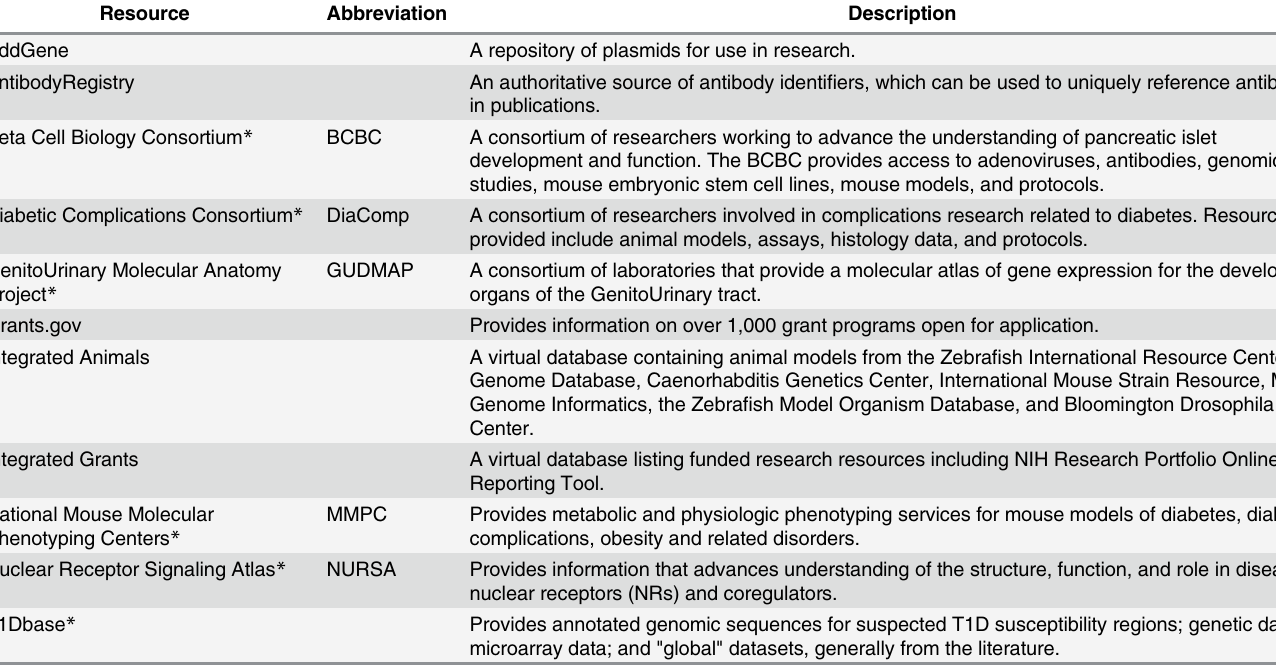
Table 1. List of resources currently available as Community Resources and abbreviations used in